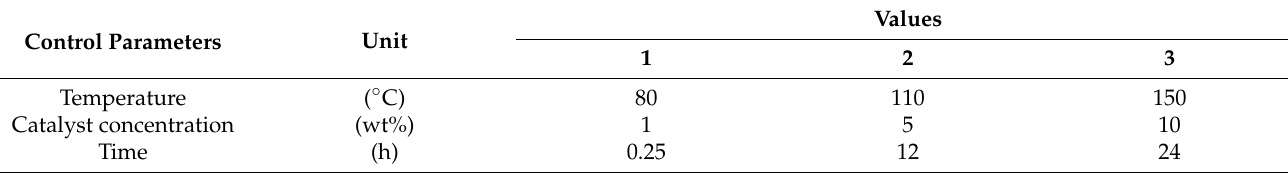
Table 3. Control parameters and values of the